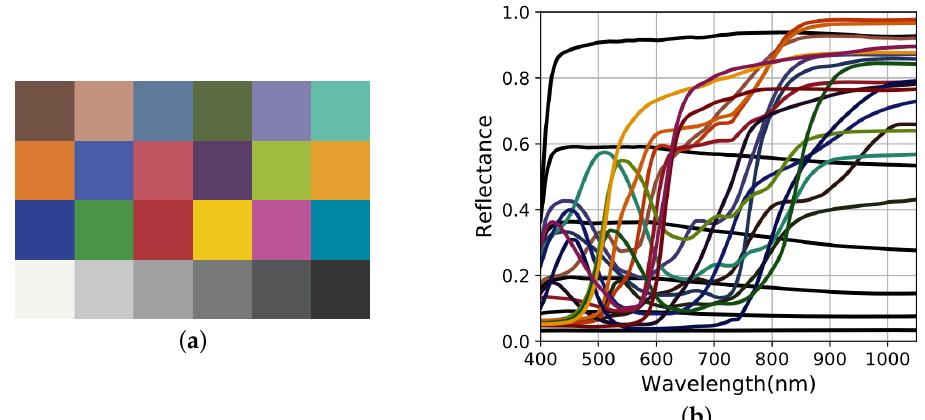
Figure 7. ( a ) Color rendering of X-Rite ColorChecker Classic. ( b ) Corresponding reflectance spectra.